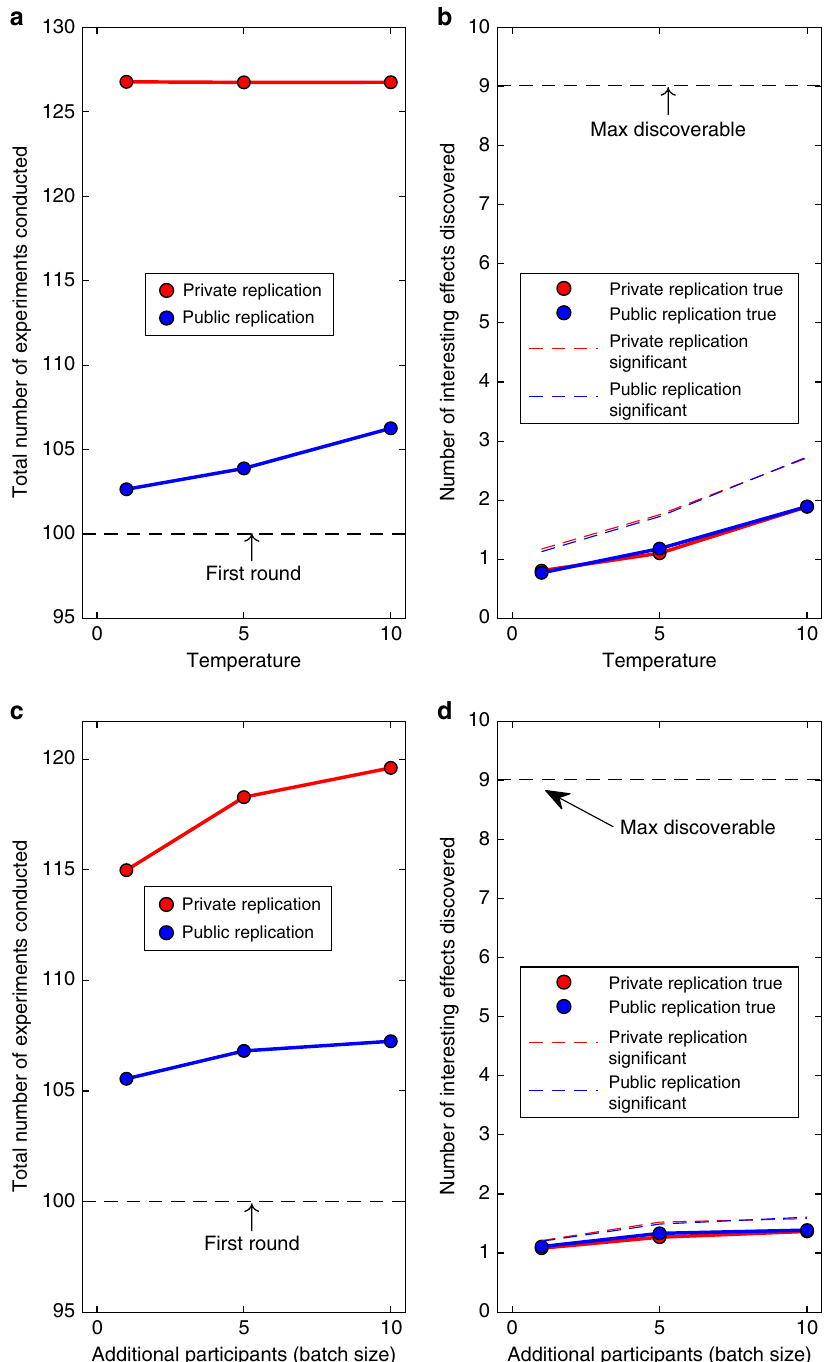
Fig. 9 Effects of perturbations of the idealized scienti fi c community. a and b show the effects of p -hacking on the number of experiments conducted and the number of effects discovered. p -hacking is operationalized by raising the type I error rate, α ¼ : 2. c and d show the effects of keeping α ¼ : 05 but adding up to fi ve batches of additional participants (each batch containing 1, 5, or 10 participants), if an effect failed to reach signi fi cance. Results are shown averaged across levels of